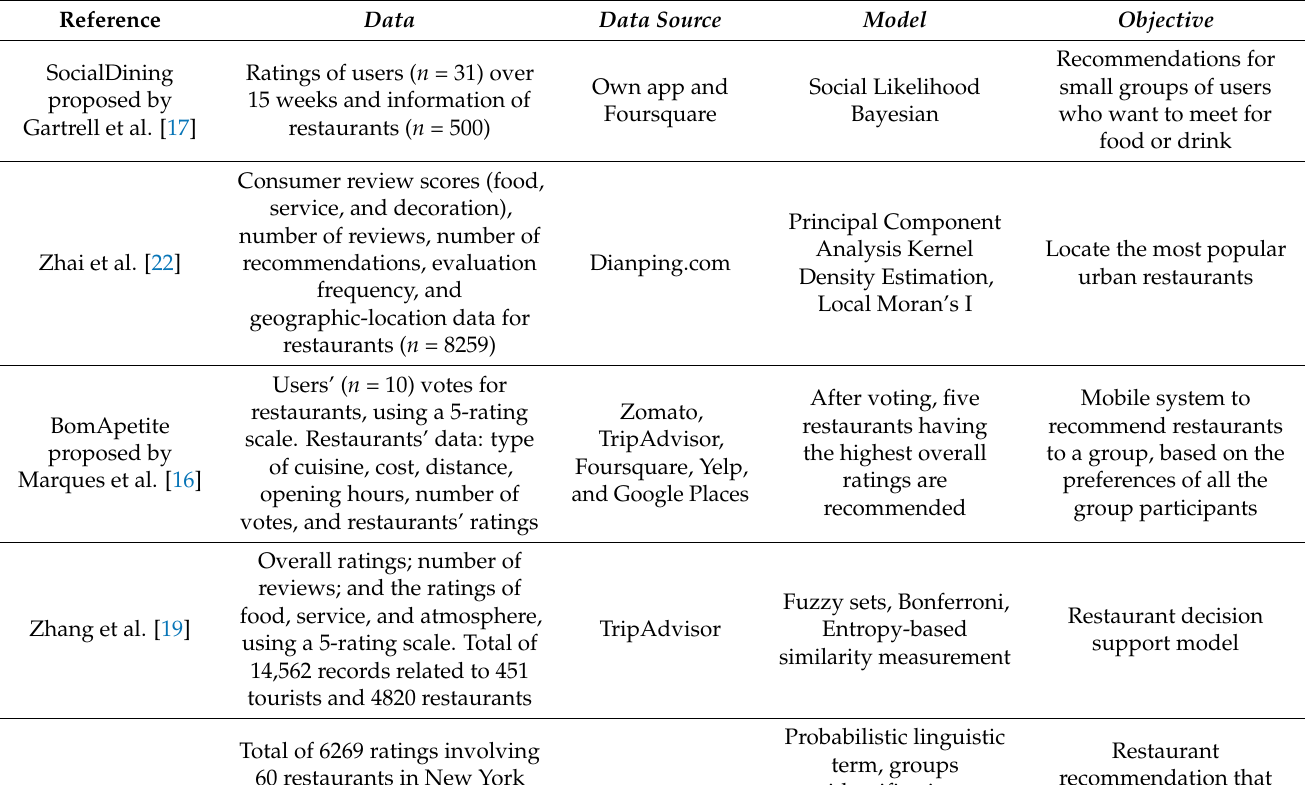
Table 1. List of of documents related to restaurants recommendation